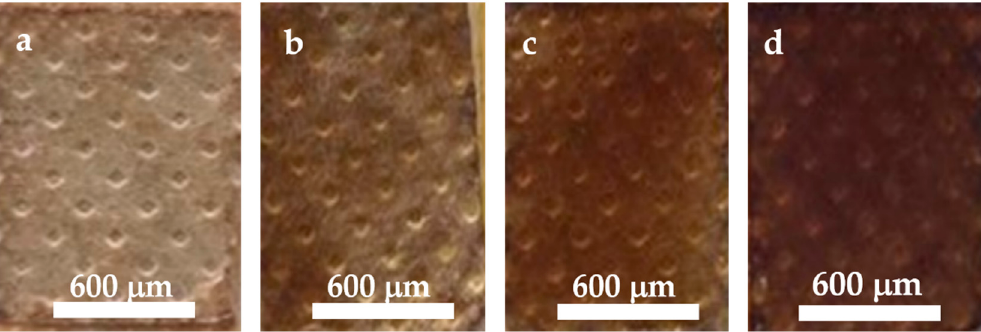
Figure 3. Plasters dip-coated in Solution A after drying: 1La, one layer ( a ); 2La, two layers ( b ); 3La, three layers ( c ); 4La, four layers ( d ).